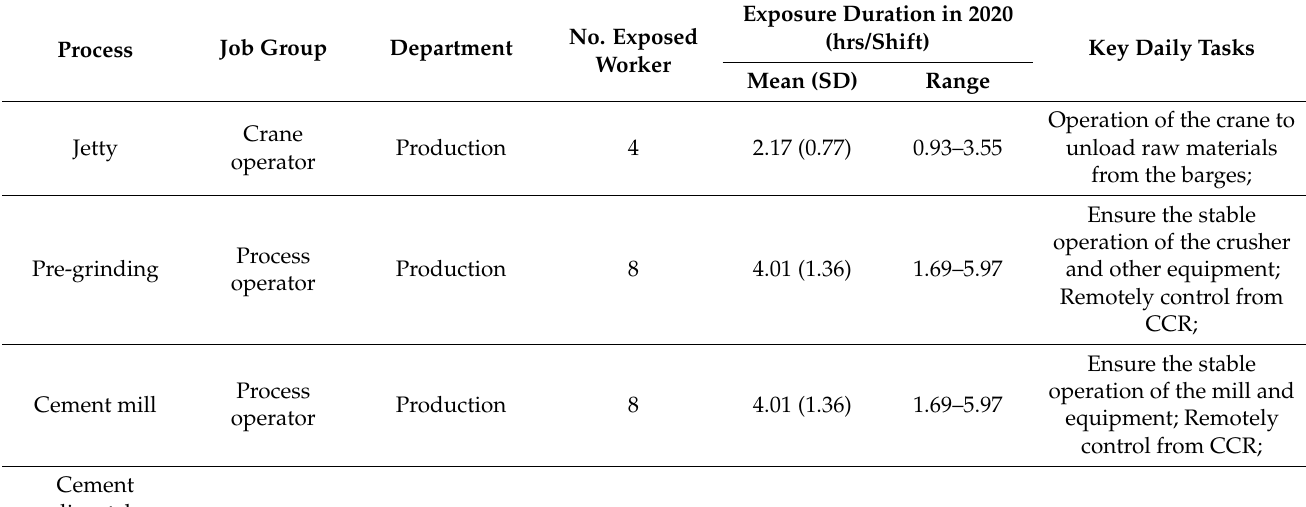
Table 1. Job group characteristics and exposure duration in the cement grinding process.